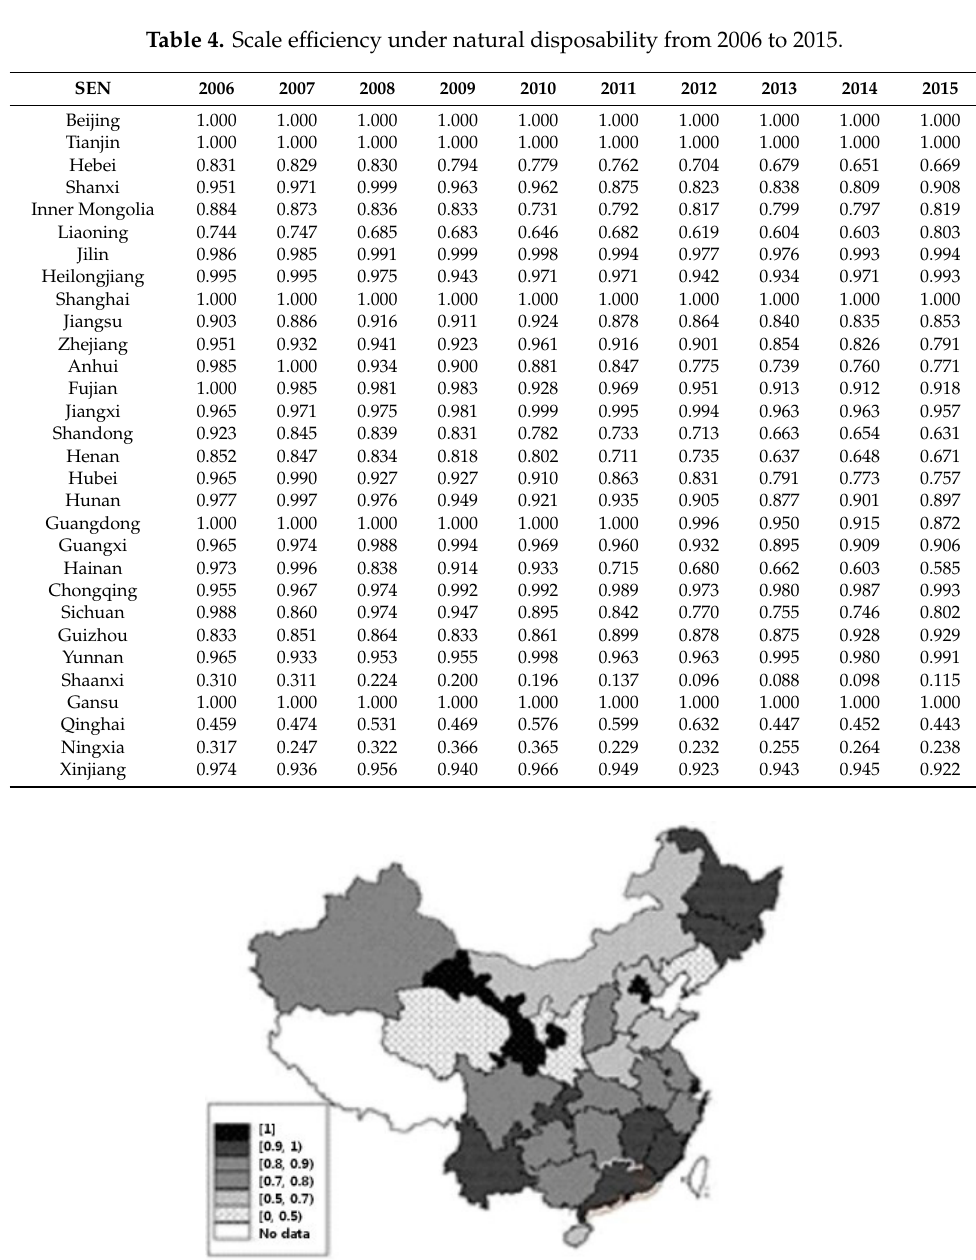
Figure 5. Average scale efficiency under the natural disposability of 30 provinces in China (2006– 2015). Table 5. Scale efficiency under managerial disposability from 2006 to 2015. SEM